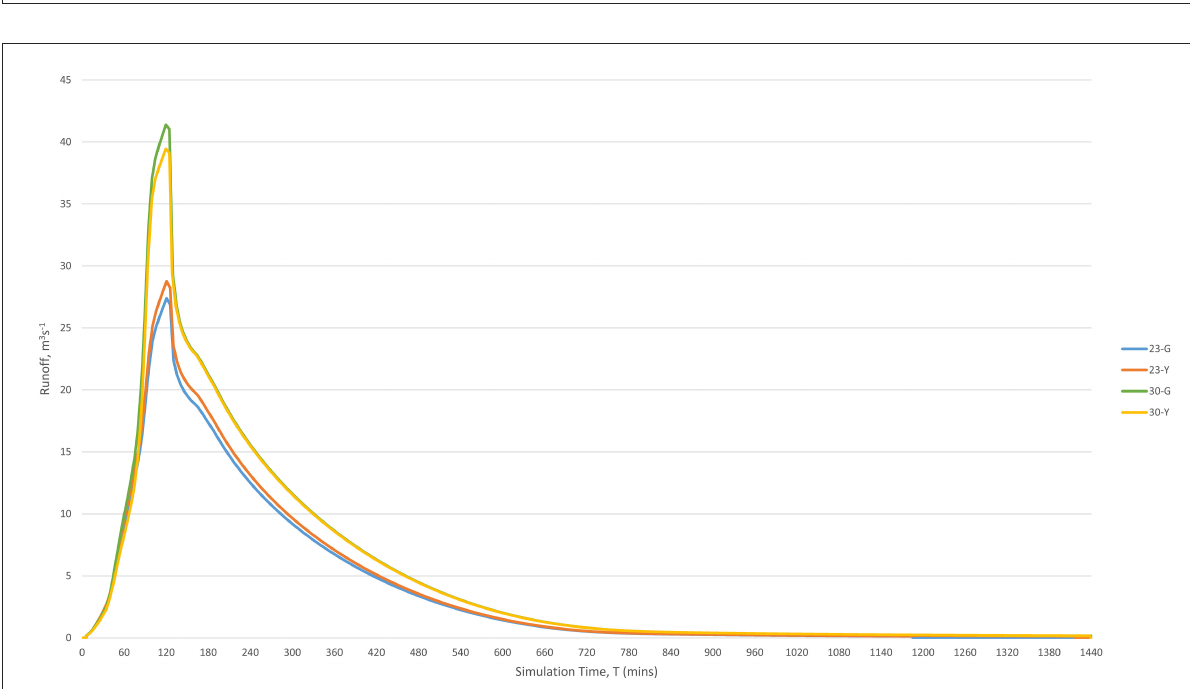
greater proportion of developed tiles shows a greater peak runoff